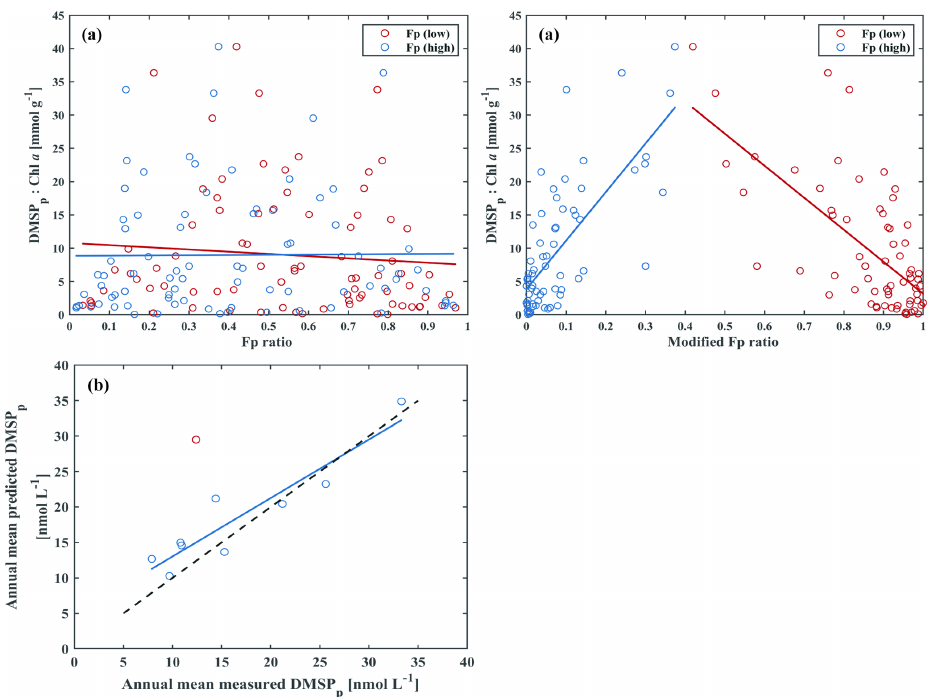
Figure 7. (a) DMSP p :Chl a vs. Fp ratio (from Nagao et al., 2018) at 5m for the period 2009–2018. (b) DMSP p :Chl a vs. modified Fp ratio (new Fp ratio) at 5m for the period 2009–2018: blue open circles depict Fp(high) ( y = 72 . 90 x + 3 . 78, R 2 = 0 . 54, p < 0 . 01, n = 65), and red open circles depict Fp(low) ( y = − 48 . 33 x + 51 . 35, R 2 = 0 . 46, p < 0 . 01, n = 65). (c) Annual mean measured DMSP p vs. annual mean predicted DMSP p concentrations at 5m for each year during 2009–2018: y = 0 . 82 x + 4 . 78, R 2 = 0 . 86, p < 0 . 01, n = 9. Note that the red open circle was not included in the linear regression line (blue), and the dash line indicates the identity (1:1)